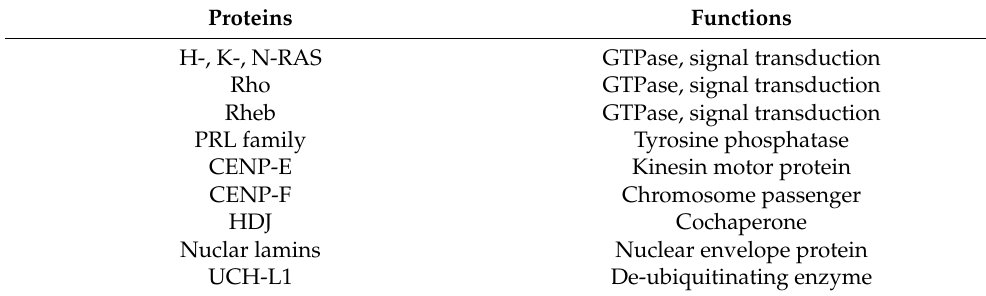
Table 1. Farnesylated